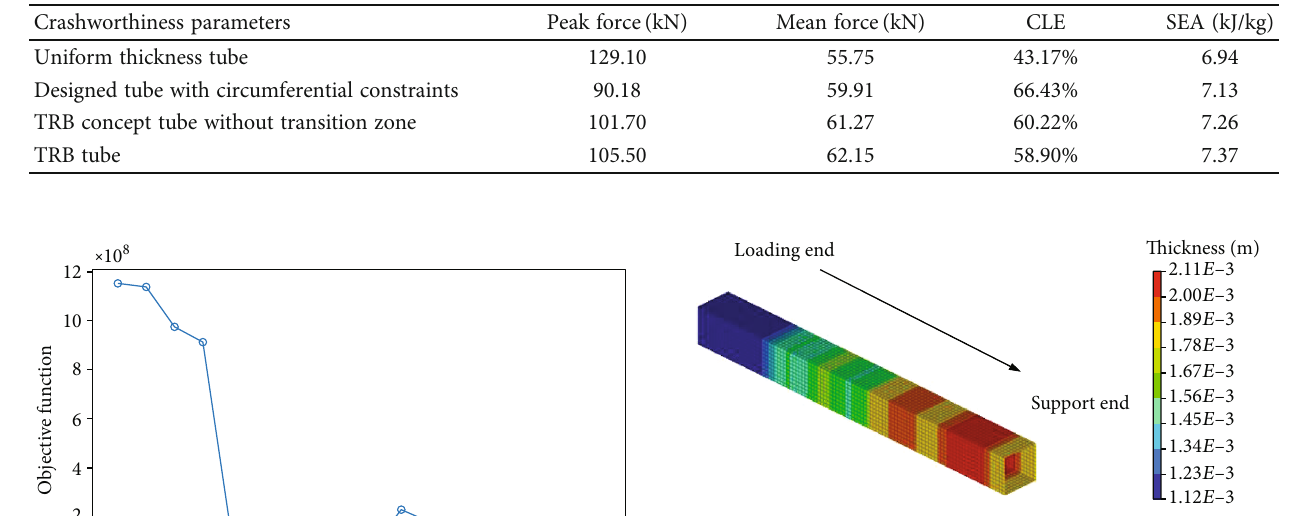
Table 5: Crashworthiness parameters of four con fi gurations of the thin-walled tube.